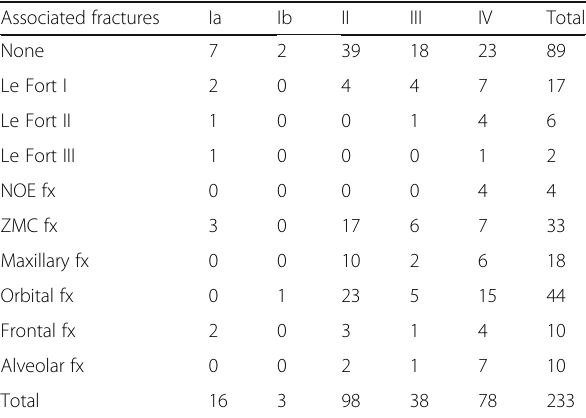
Table 5 Types of associated fracture Associated fractures